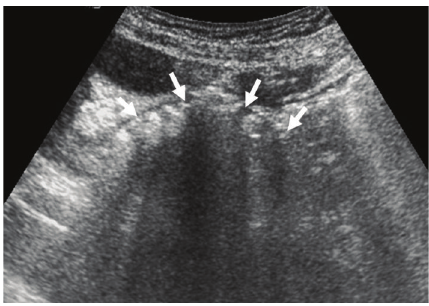
Figure 1: A gray-scale trans abdominal US image obtained at axial plane shows a mass (arrows) within duodenum having a smooth and curvilinear surface, and causing posterior acoustic